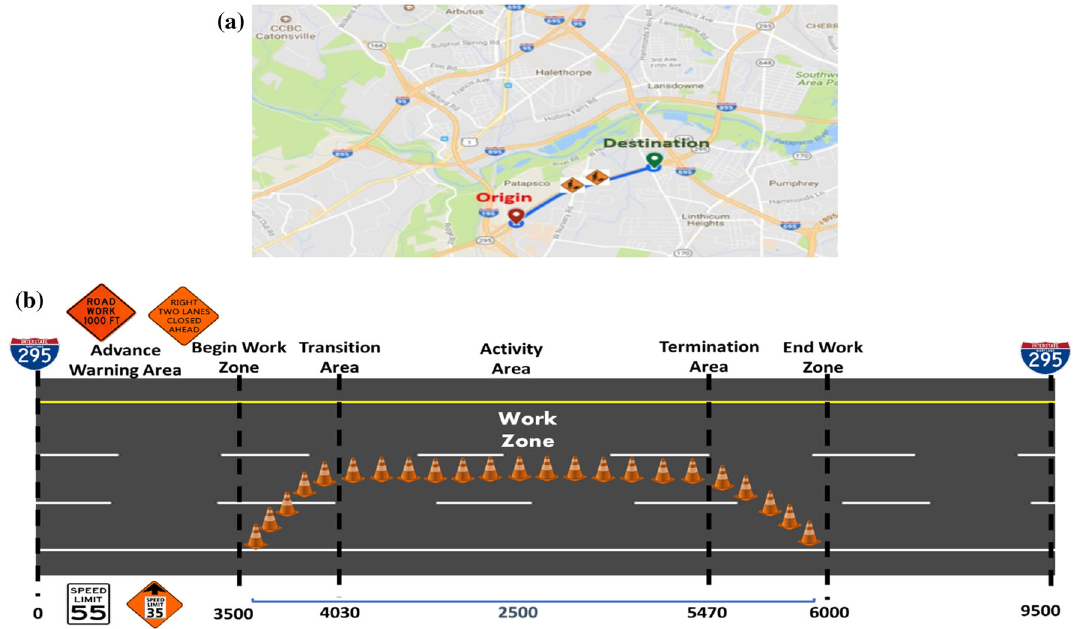
Fig. 2 The study corridor (all dimensions are in feet and are not to scale). a Work zone on MD-295, Baltimore, b work zone schematic (control